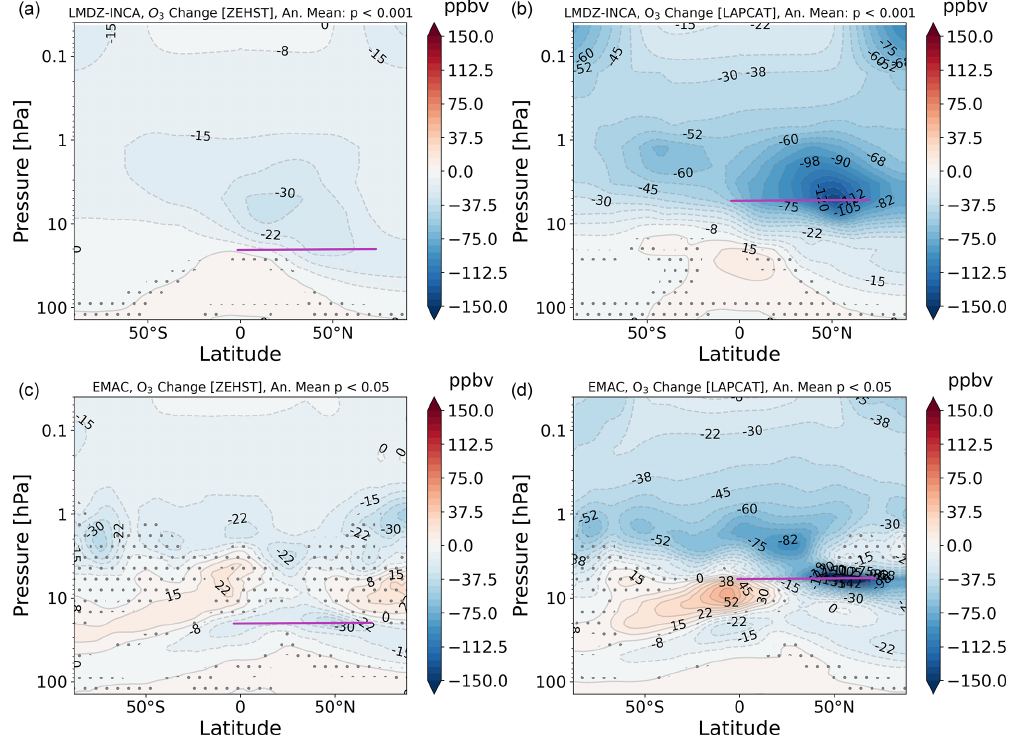
Figure 9. Multi-annual mean (2010–2014) of ozone perturbation (ppbv) for the ZEHST scenario (a, c) and the LAPCAT scenario (b, d) for both models LMDZ-INCA (a, b) and EMAC (c, d) . Purple lines represent respective cruise altitudes. Hatched areas are characterized by a p value higher than the threshold indicated in the title of each